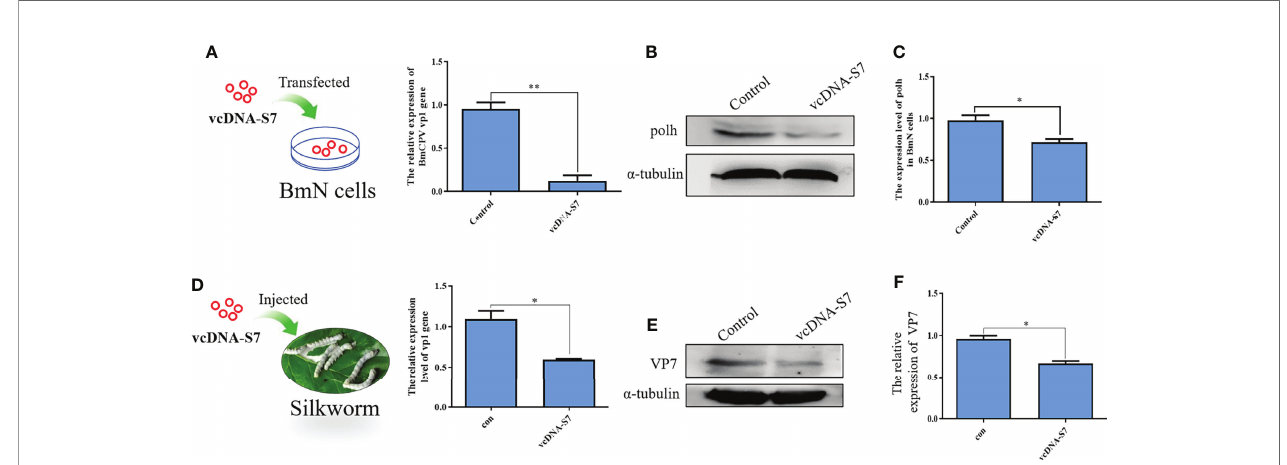
FIGURE 5 | vcDNA-S7 inhibited BmCPV infection. (A – C) vcDNA-S7 down-regulated the expression level of BmCPV vp1 gene and polh protein in BmN cells. BmN cells (1×10 6 ) were transfected with 1 m g vcDNA-S7 for 24 h and were infected with BmCPV for another 48 h. The expression levels of vp1 gene relative to translation initiation factor (TIF-4A) were investigated by real-time PCR (A) . The level of Polh protein was analyzed by western blotting (B) . The grayscale of western blotting signal bands is analyzed by software Image J (C) . (D – F) Injection of vcDNA-S7 into silkworm down-regulated the expression level of BmCPV vp1 gene and VP7 protein in BmN cells. The silkworm larvae of fourth instar were injected 1 m g of vcDNA-S7 for 24 h and were infected with BmCPV for another 48 h. The expression levels of vp1 gene relative to translation initiation factor (TIF-4A) were investigated by real-time PCR (D) . The protein level of VP7 was analyzed by western blotting (E) . The grayscale of western blotting signal bands is analyzed by software Image J (F) . (n=2, * P <0.05; ** P